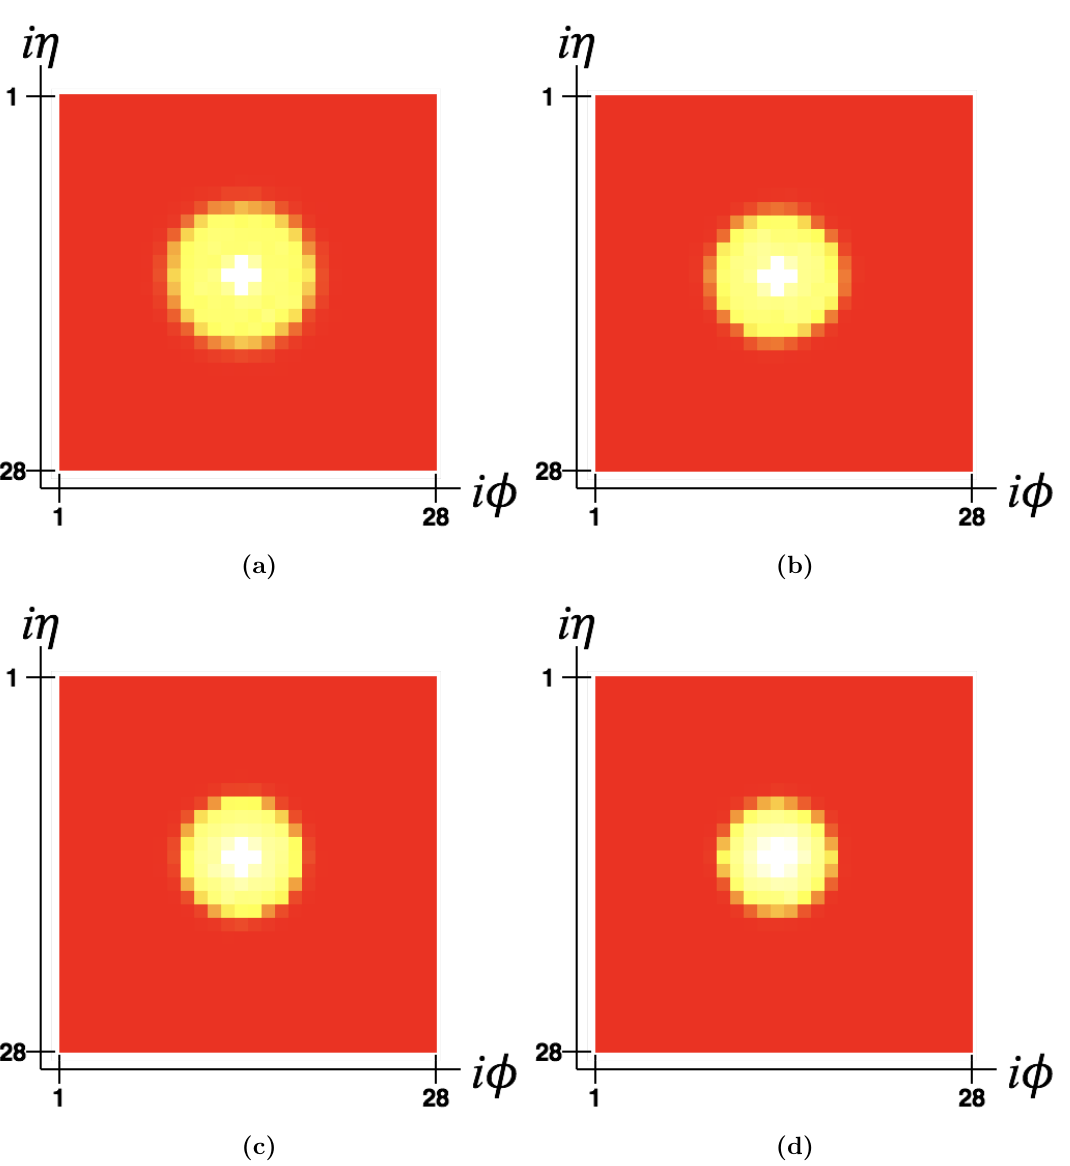
Figure 7. Average of 50,000 images for (a) prompt jets from X ; (b), (c), (d) jets displaced within 30 (cid:0) 50 cm, 50 (cid:0) 70 cm and 70 (cid:0) 90 cm transverse distance from PV respectively. These are 28 (cid:2) 28 images in the i(cid:17) (cid:0) i(cid:30) plane with the highest energy bin in the center (14,14). With increasing displacement, the energy deposition is contained to smaller i(cid:17) (cid:0) i(cid:30) region. Here we do not show the 200{220 cm displaced case, for which the energy deposition is contained in a very small region.